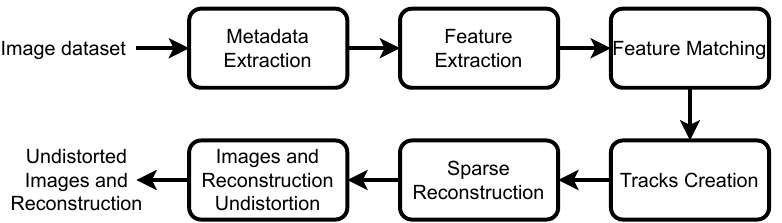
Figure 12. Sequential diagram representing the applied Structure from Motion